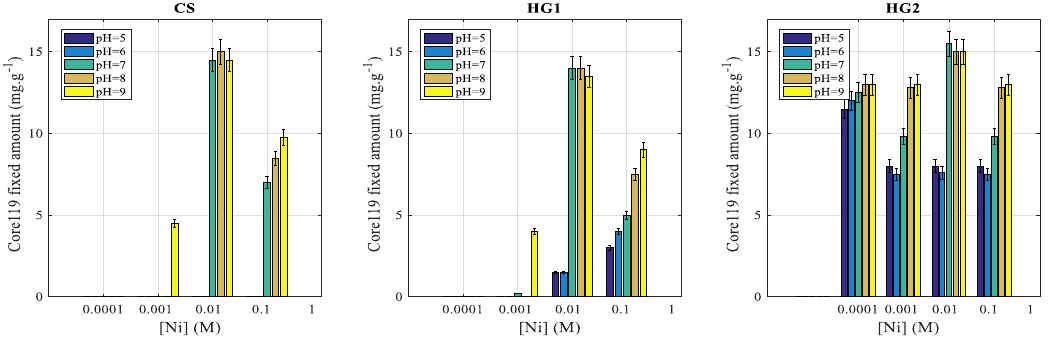
Figure 7. Effect of nickel concentration onto Core 119 fixation for core-shell (CS) particles, nanohydrogels HG1 and HG2. Conditions: phosphate buffers at different pH (ranging from 5 to 9), at 20 °C and for various [Ni] from 10 –4 M to 10 –1 M.